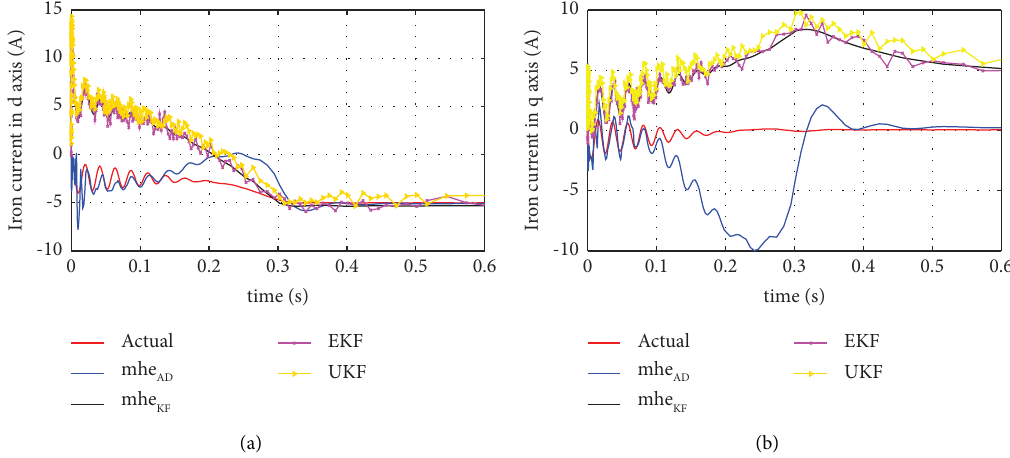
Figure 3: (a) Estimation of iron current in d axis. (b) Estimation of iron current in q